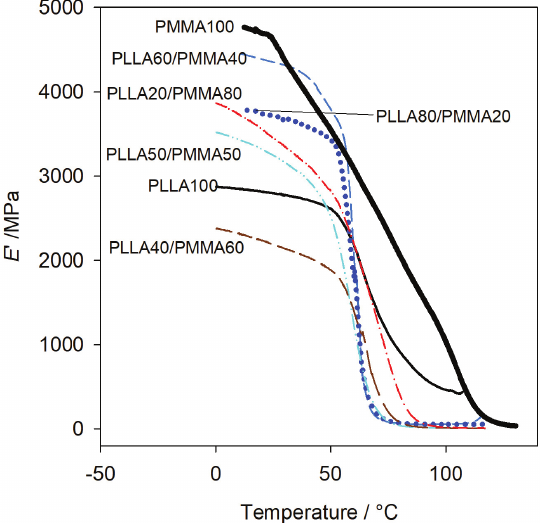
Fig. 11 – Tan δ of pure PLLA, PMMA, and PLLA/PMMA blends as a function of temperature